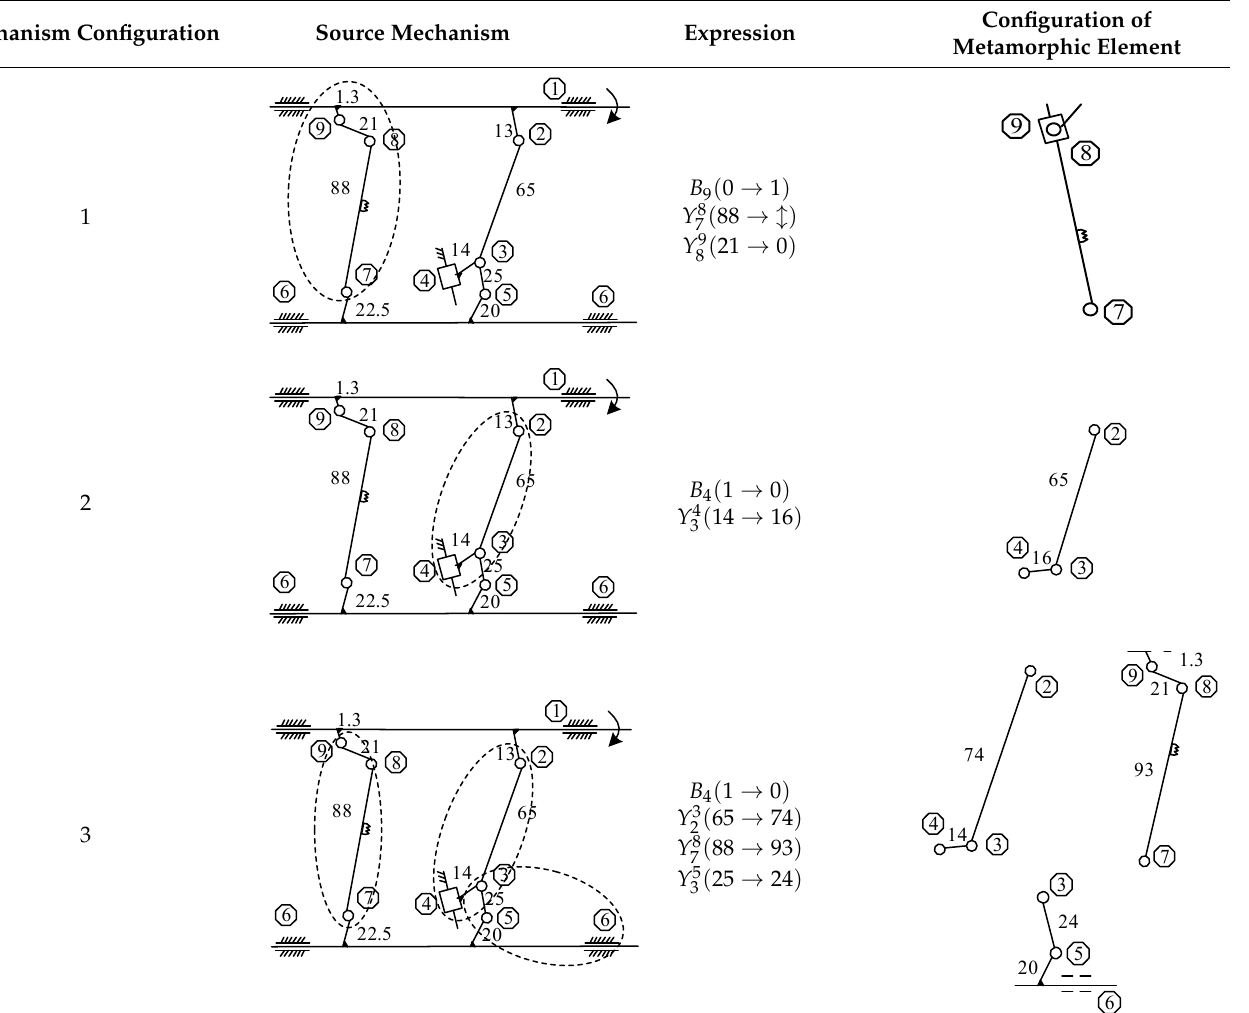
Table 2. Variation modes of metamorphic elements.